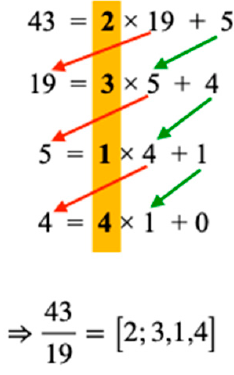
Figure 2. Using the Euclidian algorithm to compute a continued fraction.